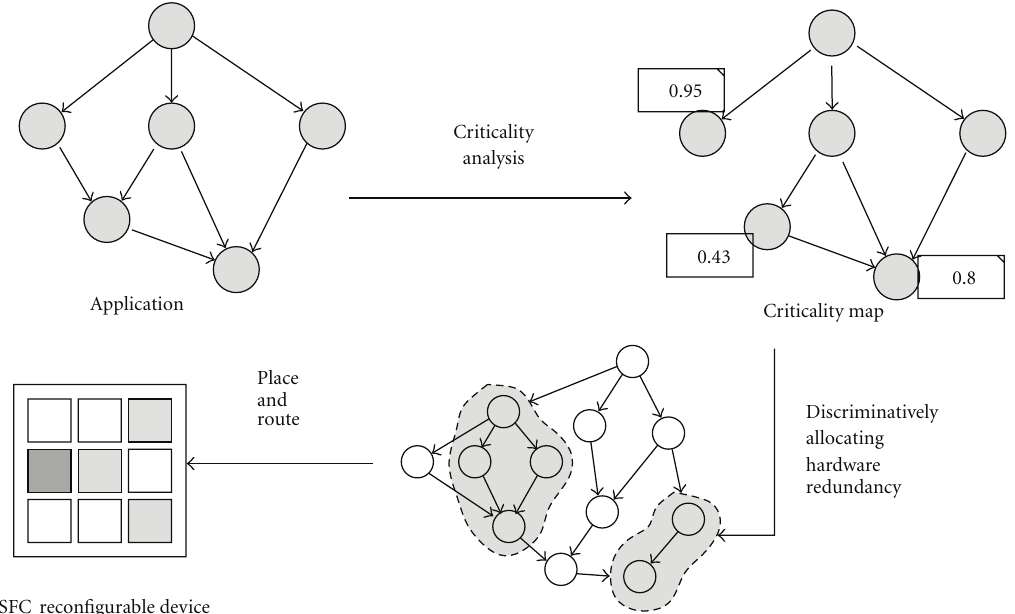
Figure 1: Conceptual flow of SFC (selectively fortified computing)